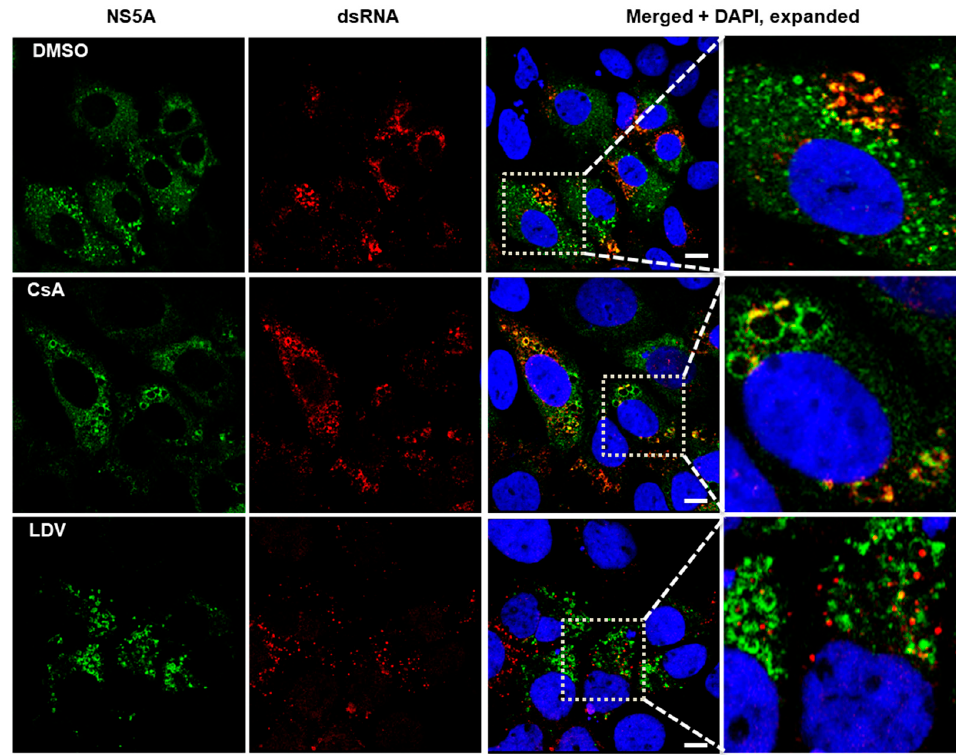
Figure 5. Localization of NS5A and dsRNA following treatment with CsA and LDV. Confocal im- munofluorescence microscopy showing the cellular distribution of NS5A and dsRNA in HCV-infected cells treated for 8 h with DMSO (first row), 100 × EC 50 CsA (second row), and LDV (third row). The cells were fixed and stained with 9E10 to label NS5A (green, first column), J2 to label dsRNA (red, second column), and DAPI to label nuclei (blue). Images were acquired on a Leica TCS SP8 microscope with a 63× oil objective. Merged images and expanded merged images show the localization of NS5A and dsRNA. The scale bar represents 10 µm. CsA, cyclosporin A; LDV, ledi- pasvir .